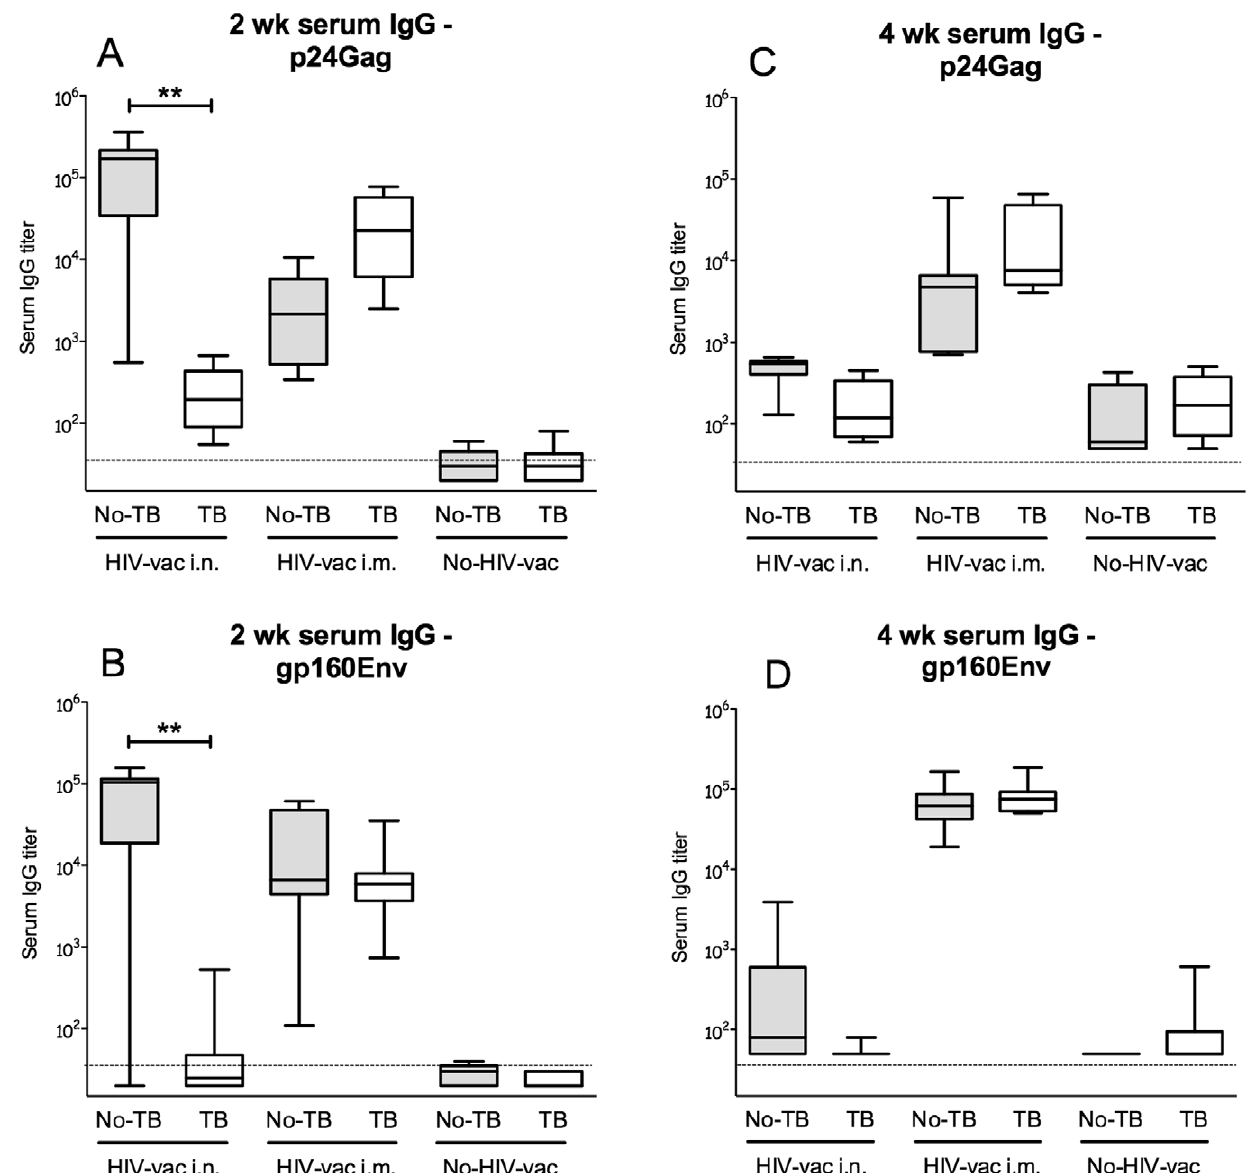
Figure 2. Effect of Mtb infection on HIV-specific serum IgG titers induced by MultiHIV DNA vaccination followed by protein boost. Uninfected or low-dose Mtb aerosol-infected (7 wk post infection) C57BL/6 mice were vaccinated i.n. or i.m. with MultiHIV DNA encoding HIV-1 subtype B gp160Env, p37Gag, Nef, Tat, and Rev in N3 adjuvant followed by two booster inoculations of recombinant HIV proteins (gp160Env, p24Gag, Tat, and Nef) in L3 adjuvant. HIV-specific serum IgG levels were measured 2 (A, B) and 4 wk (C, D) post-vaccination with HIV antigen-ELISA using p24Gag (A, C) and gp160Env (B, D) as coating antigens, as described in Materials and Methods. Median endpoint titer of 6–8 mice/group from one individual experiment is shown as a solid line. The box defines the 75th and 25th percentiles and the whiskers define the maximum and minimum values. Dashed line indicates the ELISA sensitivity threshold. (*: P , 0.05; **: P , 0.01). The IgG titers were examined in two separate